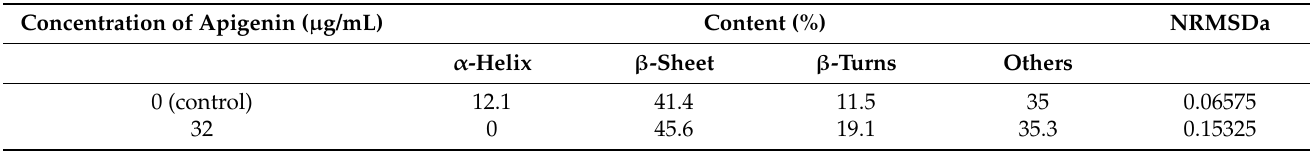
Table 1. Determination of secondary structure components of suilysin (SLY) treated with apigenin at different concentrations.